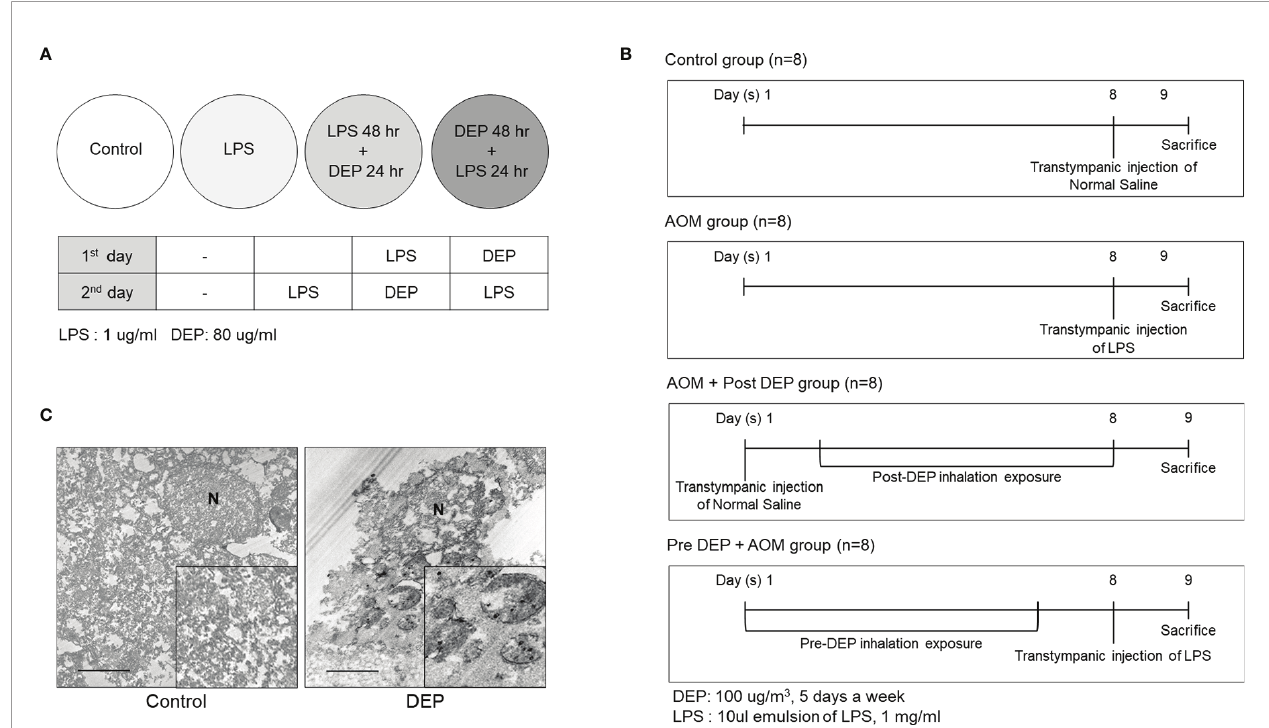
FIGURE 2 | Study design and DEP inhalation in a mouse model of acute otitis media induced by transtympanic LPS injection. (A) HMEECs were treated with a cytotoxic dose of LPS (1 µg/mL) and DEP (80 µg/mL) for 24 hr and 48 hr, or both in different sequences or simultaneously as indicated. (B) Experimental protocol for DEP exposure in a mouse model of AOM (n = 13 in each group) (DEP 100 µg/m 3 ; 10 µL emulsion of 1 mg/mL LPS). (C) The DEP were observed in transmission electron microscopy images inside eustachian tube cells connected to tissues only among mice that inhaled 100 µg/m 3 DEP for 1 hr a day for 5 days a week (N, nucleus; scale bar, 1 µm; magni fi cation ×30,000). LPS, lipopolysaccharide; DEP, diesel exhaust particles; HMEECs, human middle ear epithelial cells; AOM, acute otitis media.